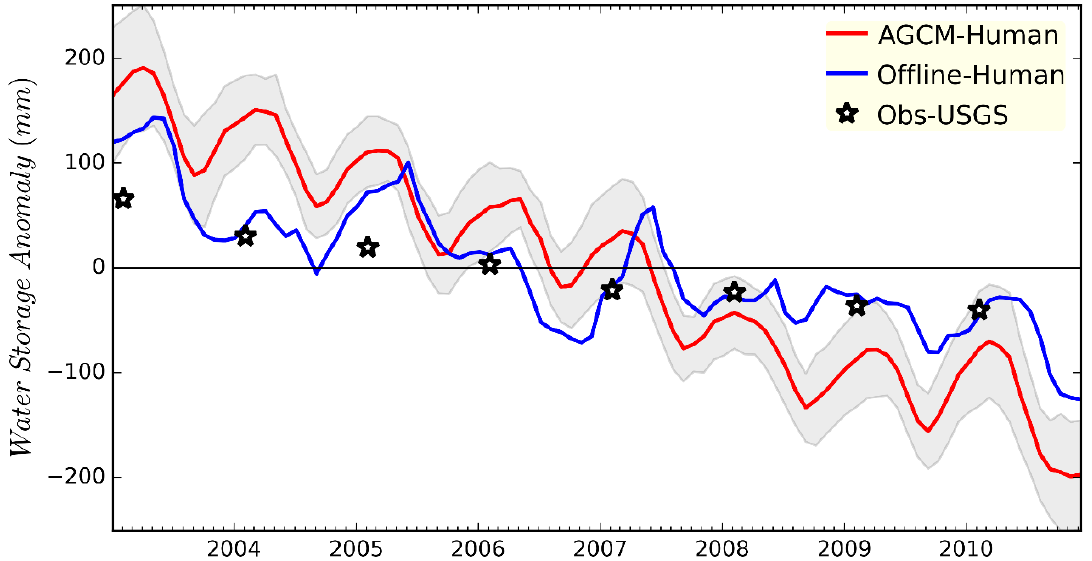
Figure 2. Comparison of simulated monthly terrestrial water storage anomalies (mm) averaged over the region overlying the High Plains aquifer with the observations from the United States Geological Survey (USGS). Blue and red lines represent the Offline–Human and AGCM–Human simulations, respectively. The USGS observations (stars), which are reported once every year in spring, are plotted in the month of February. The gray shading denotes ± 1 standard deviation from the mean for ten ensemble simulations.